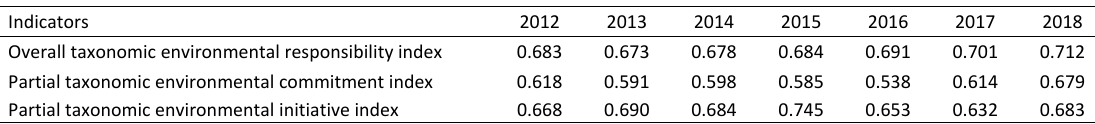
Table 8: Taxonomic indices of environmental responsibility, environmental commitment and environmental initiative for the period 2012-2018 Indicators